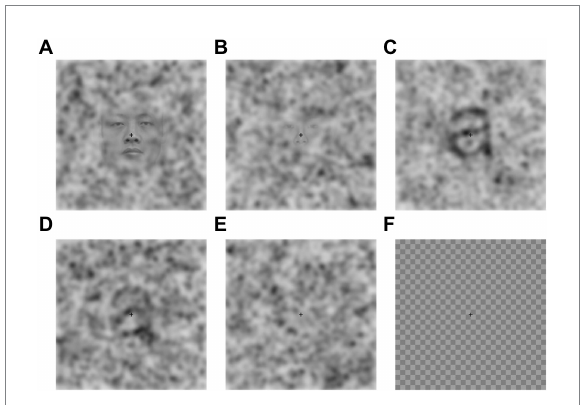
FIGURE 2 Example stimuli for the Noise Pareidolia face (A,B) and letter (C,D) detection task as well as pure noise (E) and a checkerboard mask (F) . Reproduced with permission without changes from Liu et al. (Liu et al.